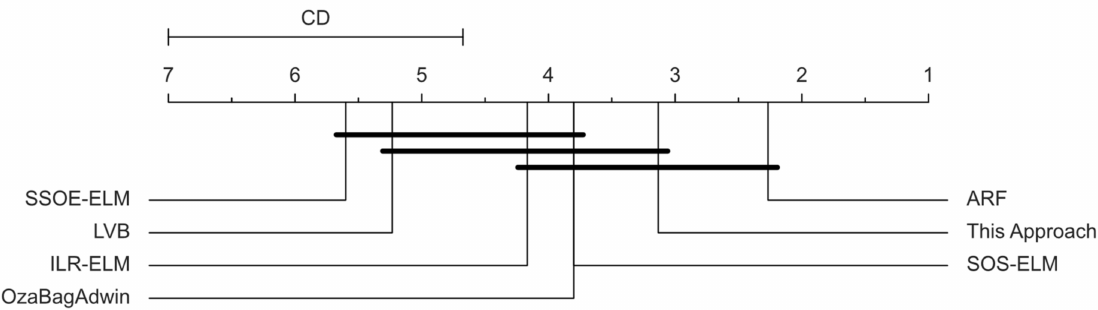
Figure 8. Critical Distance diagram of performance ranking comparison in real-world